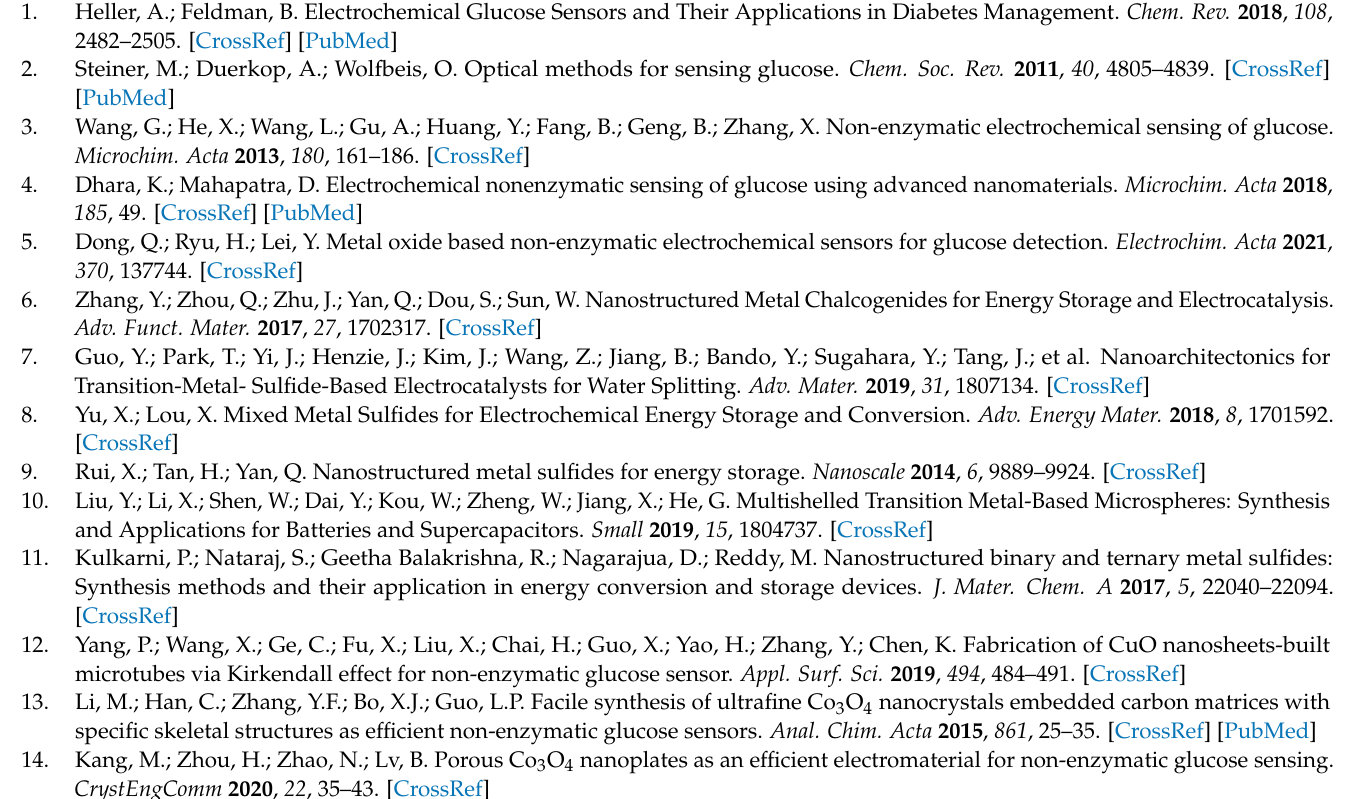
sample; Figure S2: XPS survey spectra of (a) CuS-1, (b) Co-CuS-1 and (c) Co-CuS-2